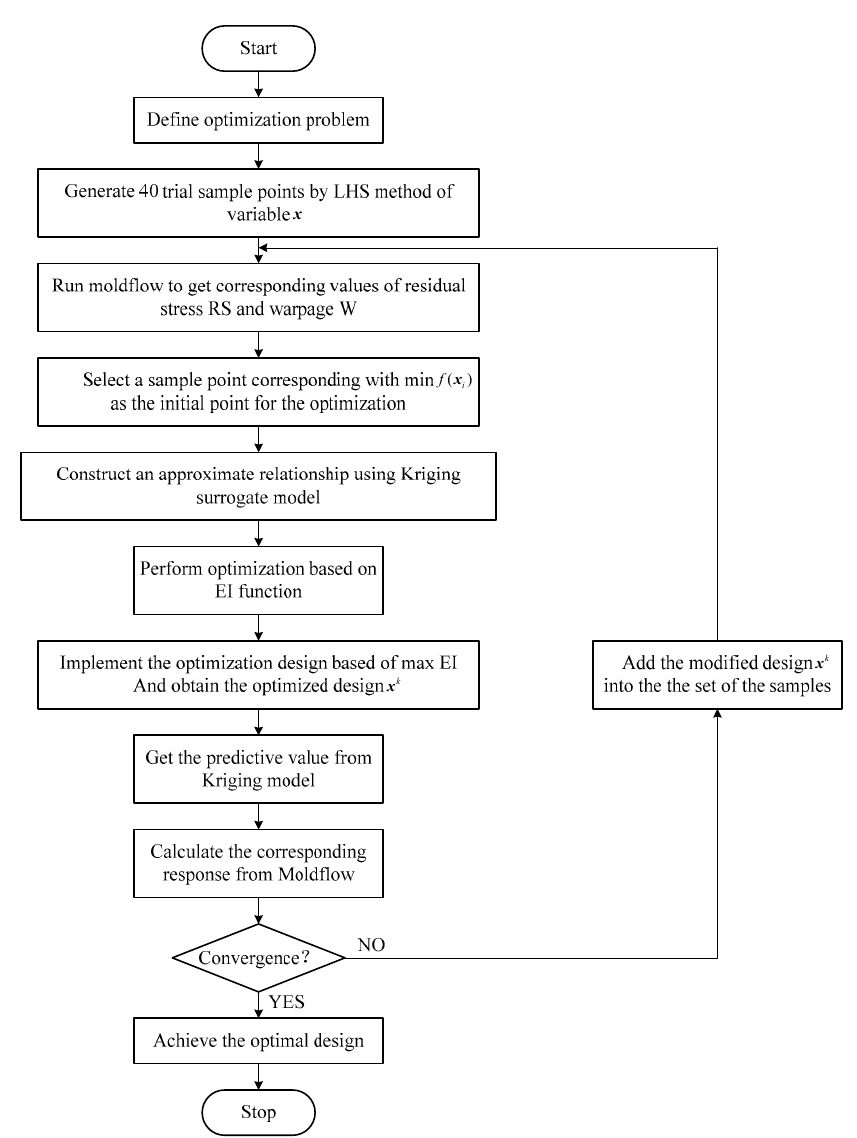
Figure 6. Complete process of the optimization algorithm based on the Kriging surrogate model.